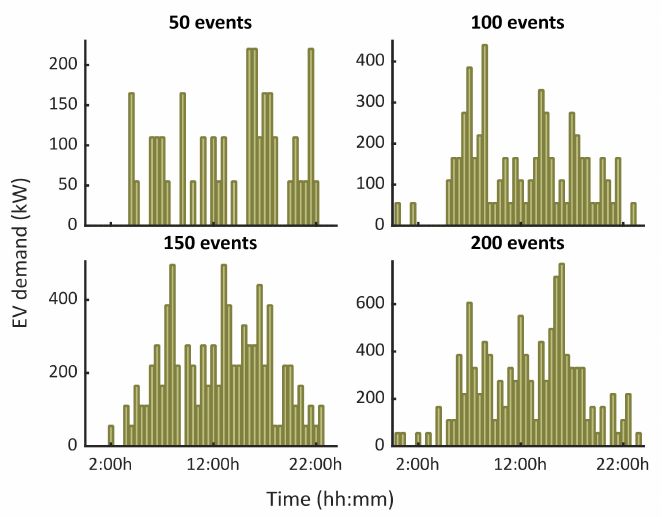
Figure 6. EV demand scenarios generated with the developed stochastic model for various numbers of expected charging